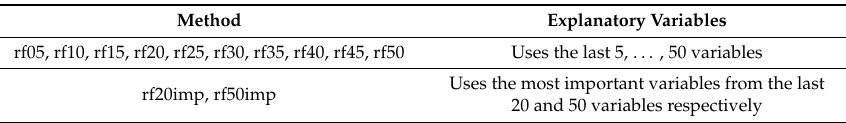
Table 3. Variable selection procedures used by the RF